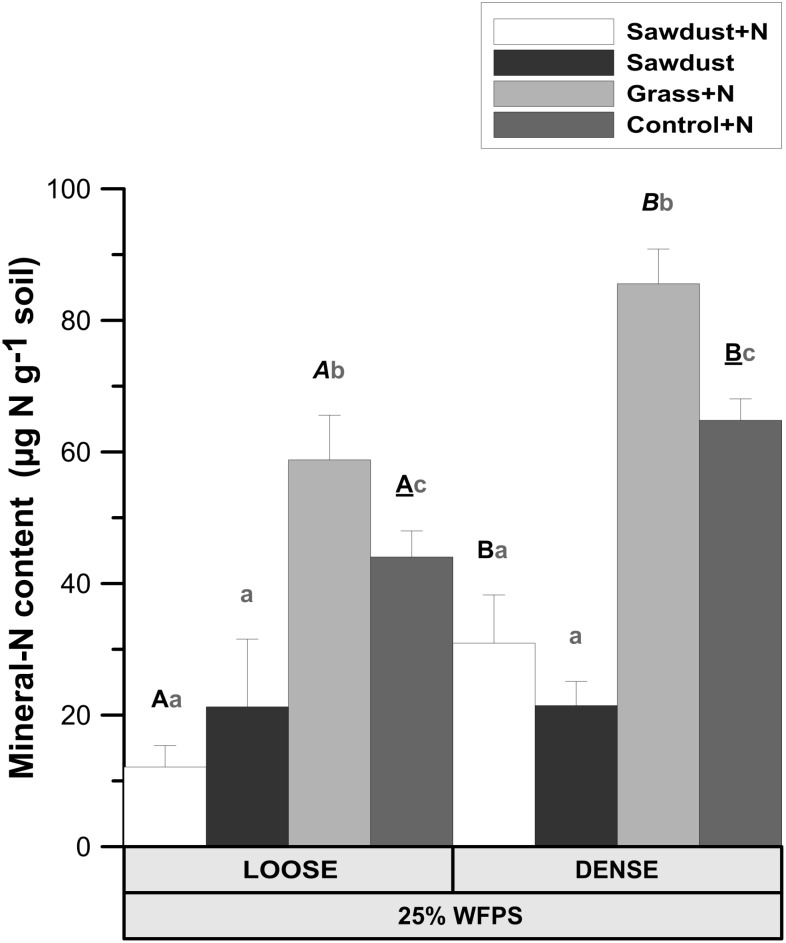
Mineral N content (NO3- + NH4+) in the soil cores at 25% WFPS after 128 days of incubation for both structure types. Error bars represent standard deviation (n = 3). Statistically different structure treatments are indicated by different capital letters, one type per substrate+N treatment: bold letters for the sawdust+N treatment, bold italic letters for the grass+N treatment and underlined bold letters for the control+N treatment. Statistically different substrate treatments within the same structure class are indicated by gray lowercase letters.